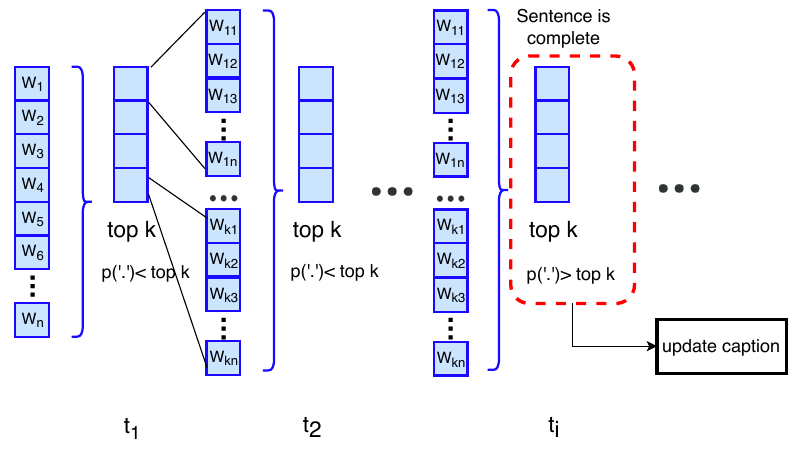
Figure 4. Our beam search